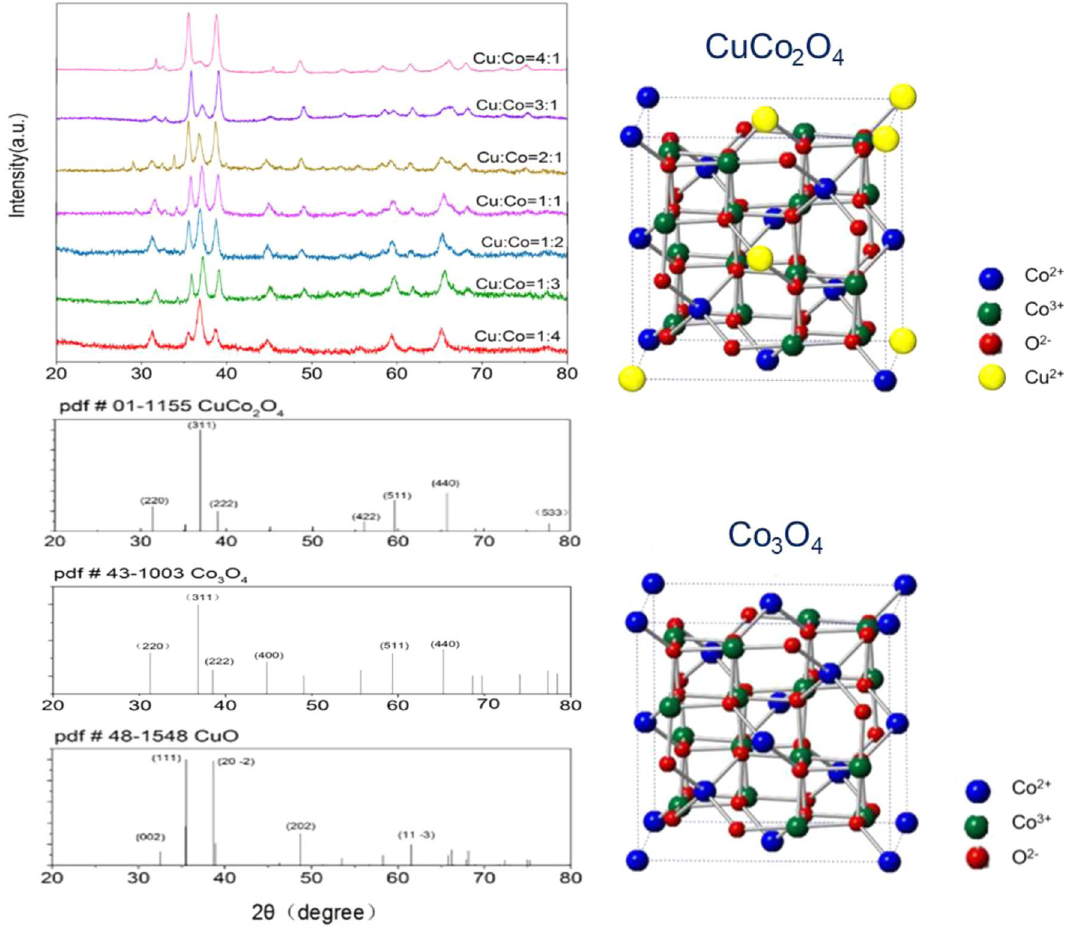
Fig. 3 XRD patterns of as-prepared Cu x Co 3− x O 4 samples with various binary metal ratio of copper and